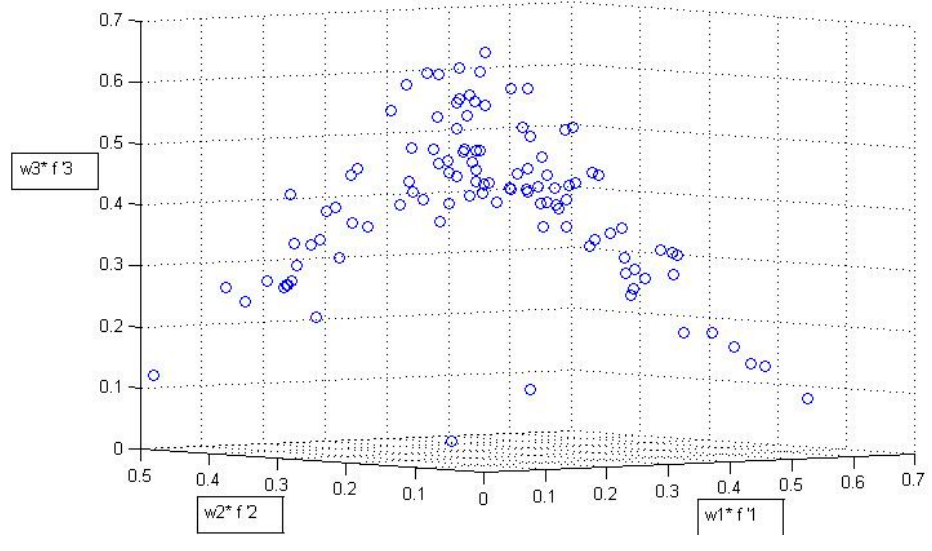
Figure 8. Non-dominated Pareto-front solutions.